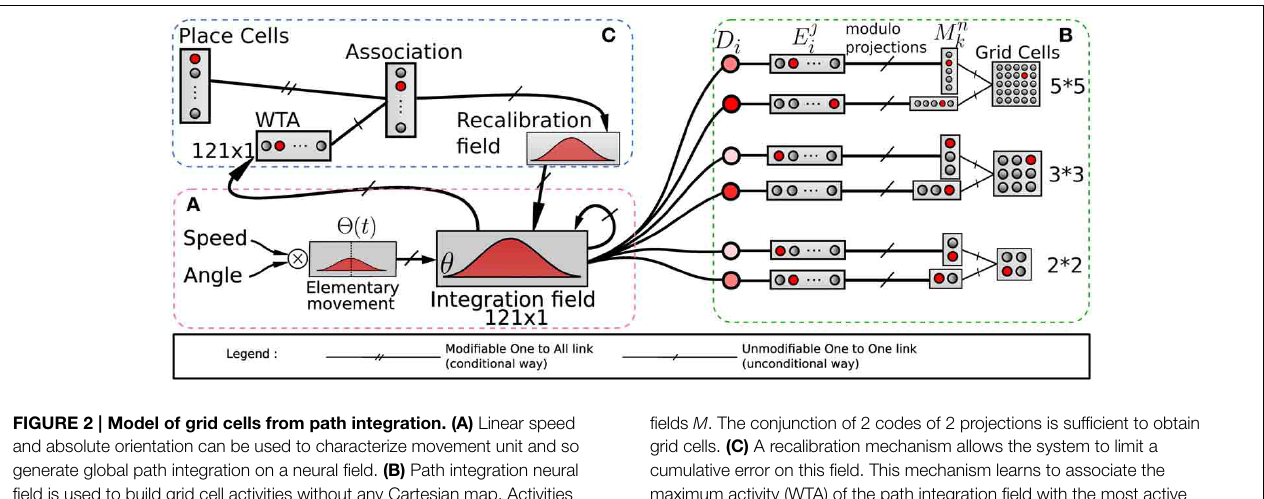
fields M . The conjunction of 2 codes of 2 projections is sufficient to obtain grid cells. (C) A recalibration mechanism allows the system to limit a cumulative error on this field. This mechanism learns to associate the maximum activity (WTA) of the path integration field with the most active visual place cell (VPC) via a least mean square learning algorithm. It allows the system to recalibrate itself when it later recognizes known visual place